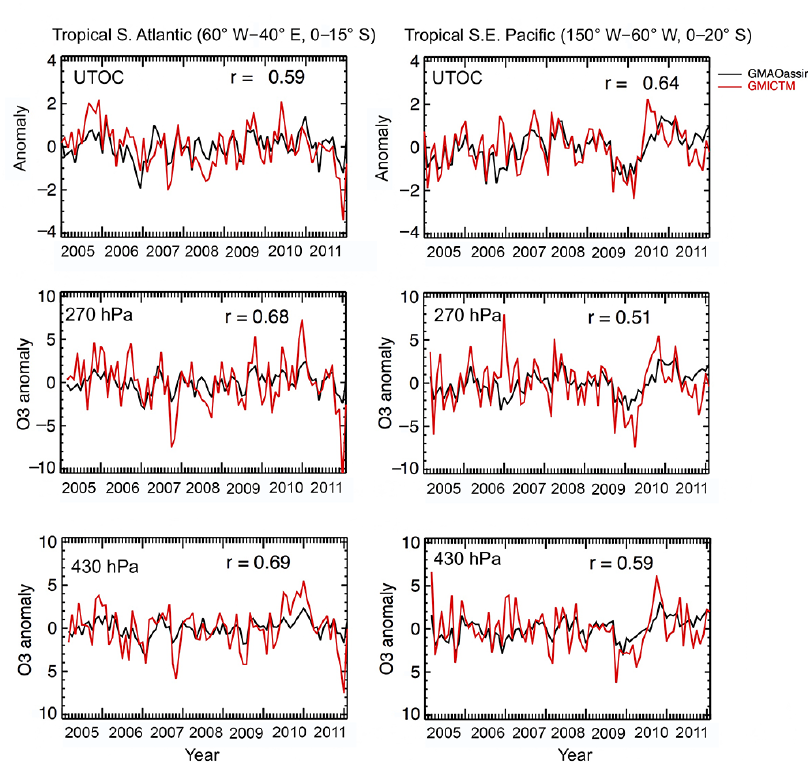
Figure 4. Time series plots of upper tropospheric ozone column (UTOC, integrated from 500hPa to the tropopause; unit: DU) anomalies and tropospheric ozone anomalies (unit: ppb) at 270 and 430hPa from GMAO assimilated data (black) and GMI-CTM (red) over (left) the tropical South Atlantic region (60 ◦ W–40 ◦ E, 0–15 ◦ S) and (right) tropical southeastern Pacific (150–60 ◦ W, 0–20 ◦ S) from 2005 to 2011. The anomalies are calculated by removing the monthly mean averaged from 2005 to